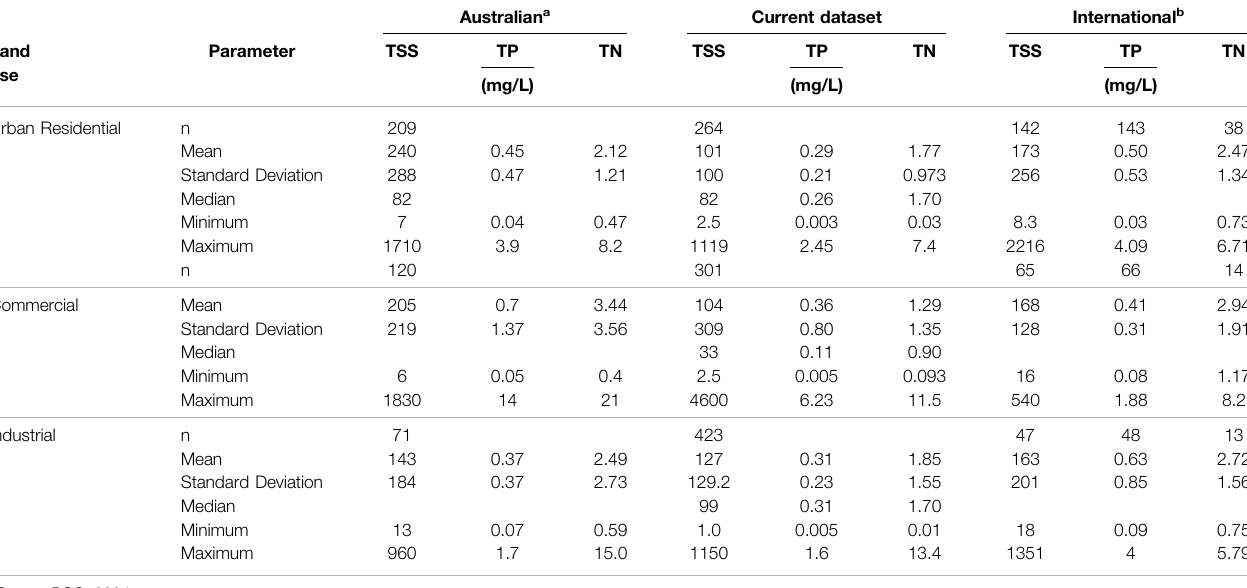
TABLE 1 | Comparison of Total Suspended Solids (TSS), Total Phosphorus (TP) and Total Nitrogen (TN) Statistics for Stormwater from Urban Residential, Industrial and Commercial Land Uses for the current dataset, historical Australian and International